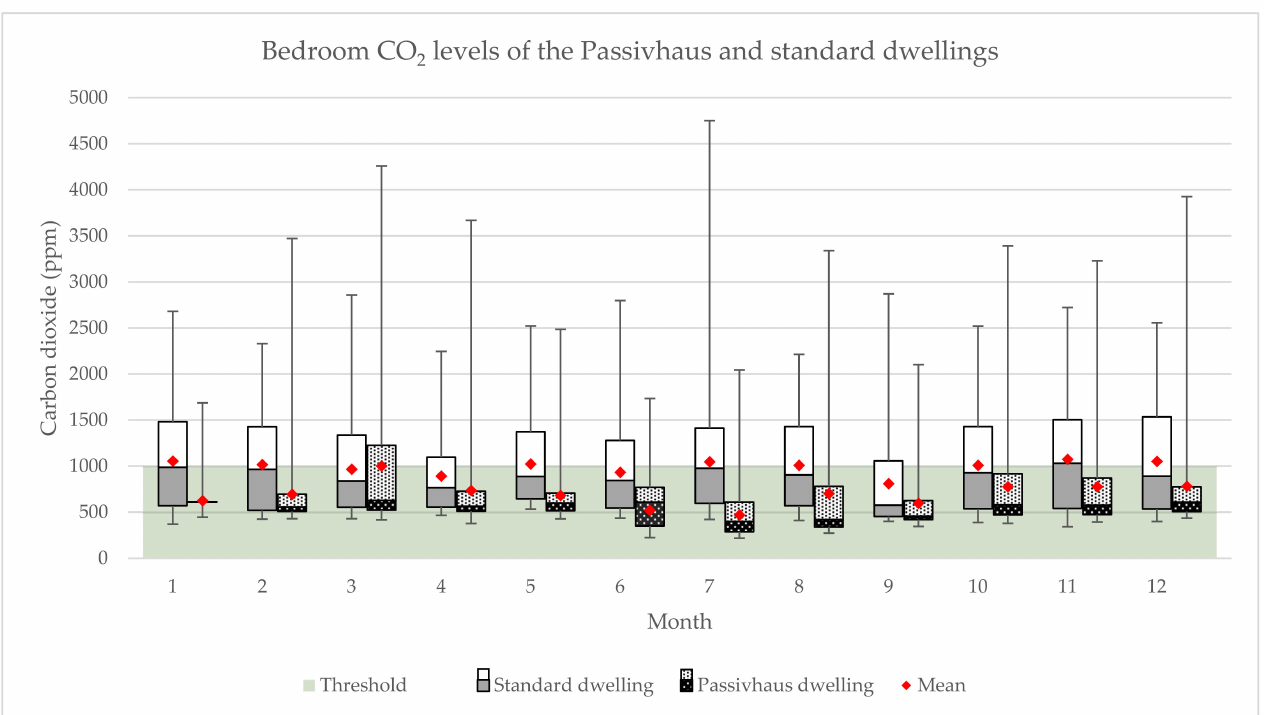
Figure 5. Bedroom annual CO 2 levels in the Passivhaus and Standard dwellings. Source: